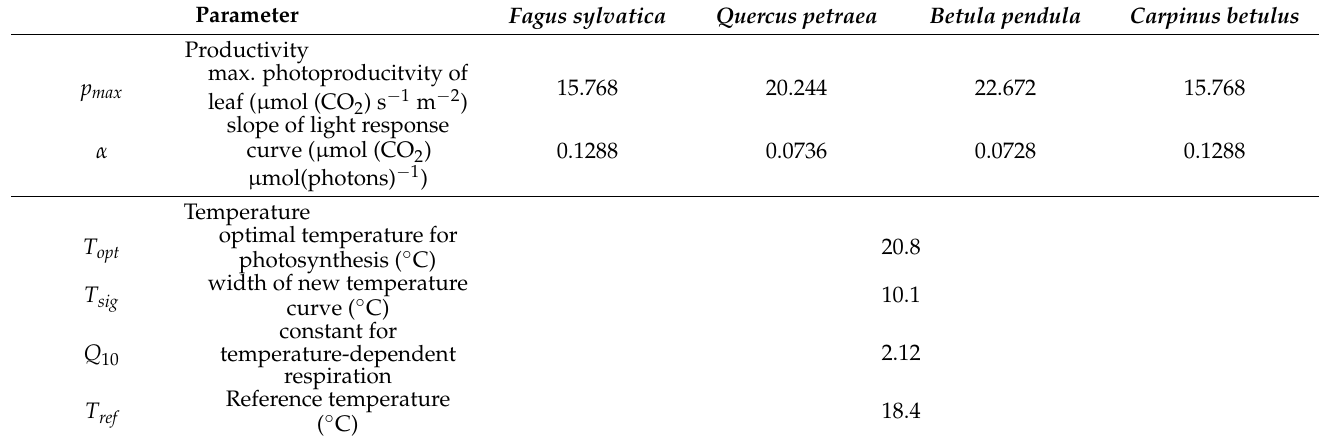
Table A2. Calibrated Model